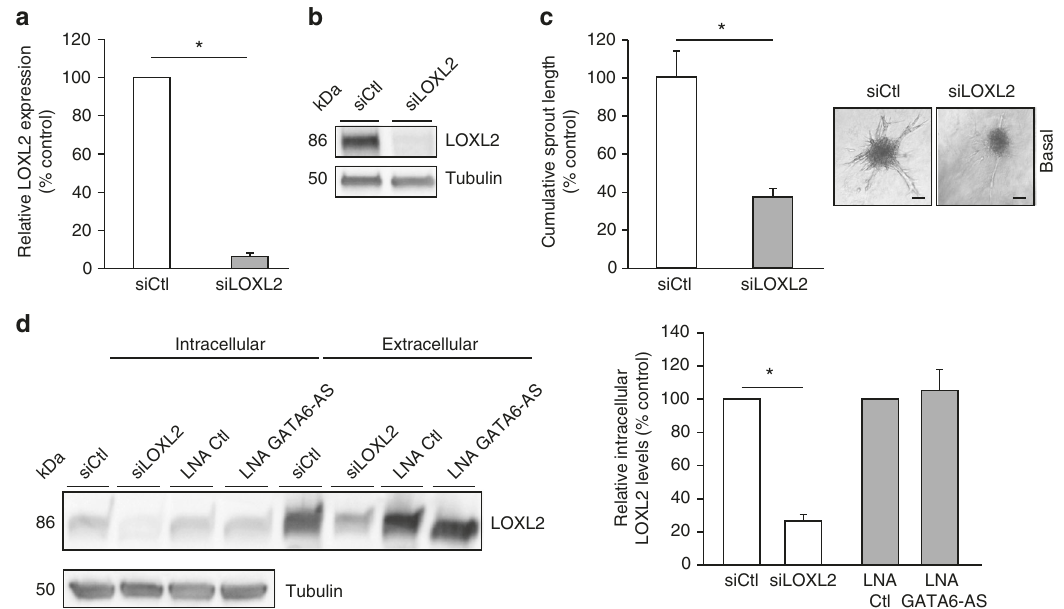
Fig. 5 GATA6-AS silencing does not in fl uence intracellular and extracellular LOXL2 levels. a HUVECs were transfected with siRNAs targeting LOXL2 or with control siRNAs and relative expression of LOXL2 was determined by RT-qPCR, normalized to RPLP0 mRNA ( n = 6; SEM; * t test p < 0.05). b LOXL2 protein levels were determined from the same cells by western blotting, using tubulin as loading control ( n = 1). c LOXL2-silenced cells or control cells were used for in vitro spheroid sprouting assays under basal conditions ( n = 6; SEM; * t test p < 0.05; representative images are shown; scale bars are 50 µ m). d HUVECs were transfected with siRNAs or GapmeRs targeting LOXL2 or GATA6-AS, respectively. Left: Intracellular and extracellular LOXL2 levels were assayed by western blotting (representative images are shown). Right: For quanti fi cation, intracellular LOXL2 levels were normalized to tubulin ( n = 5 – 6; SEM; * t test p <